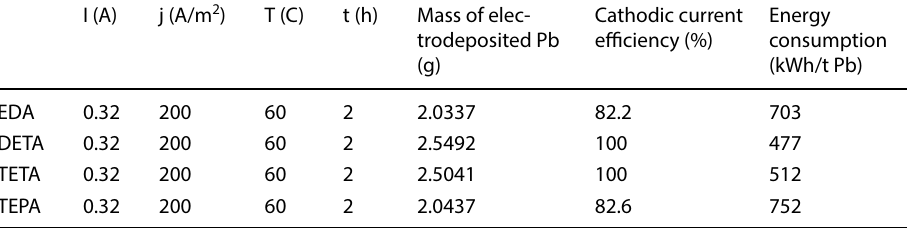
Table 1 Parameters of electrodeposition